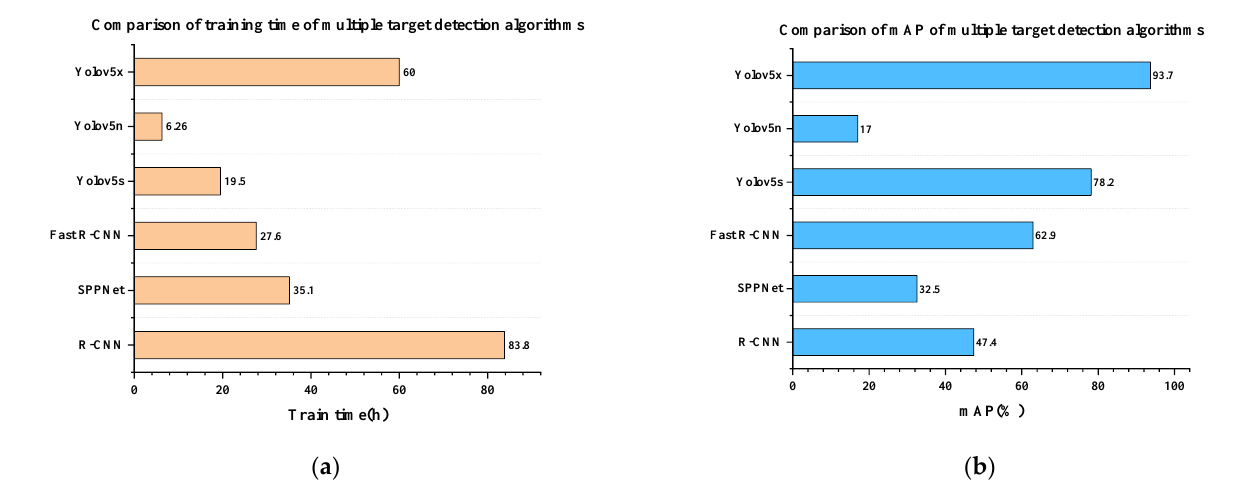
Figure 16. ( a ) Training time of different object detection models. ( b ) mAP values of different object detection models.